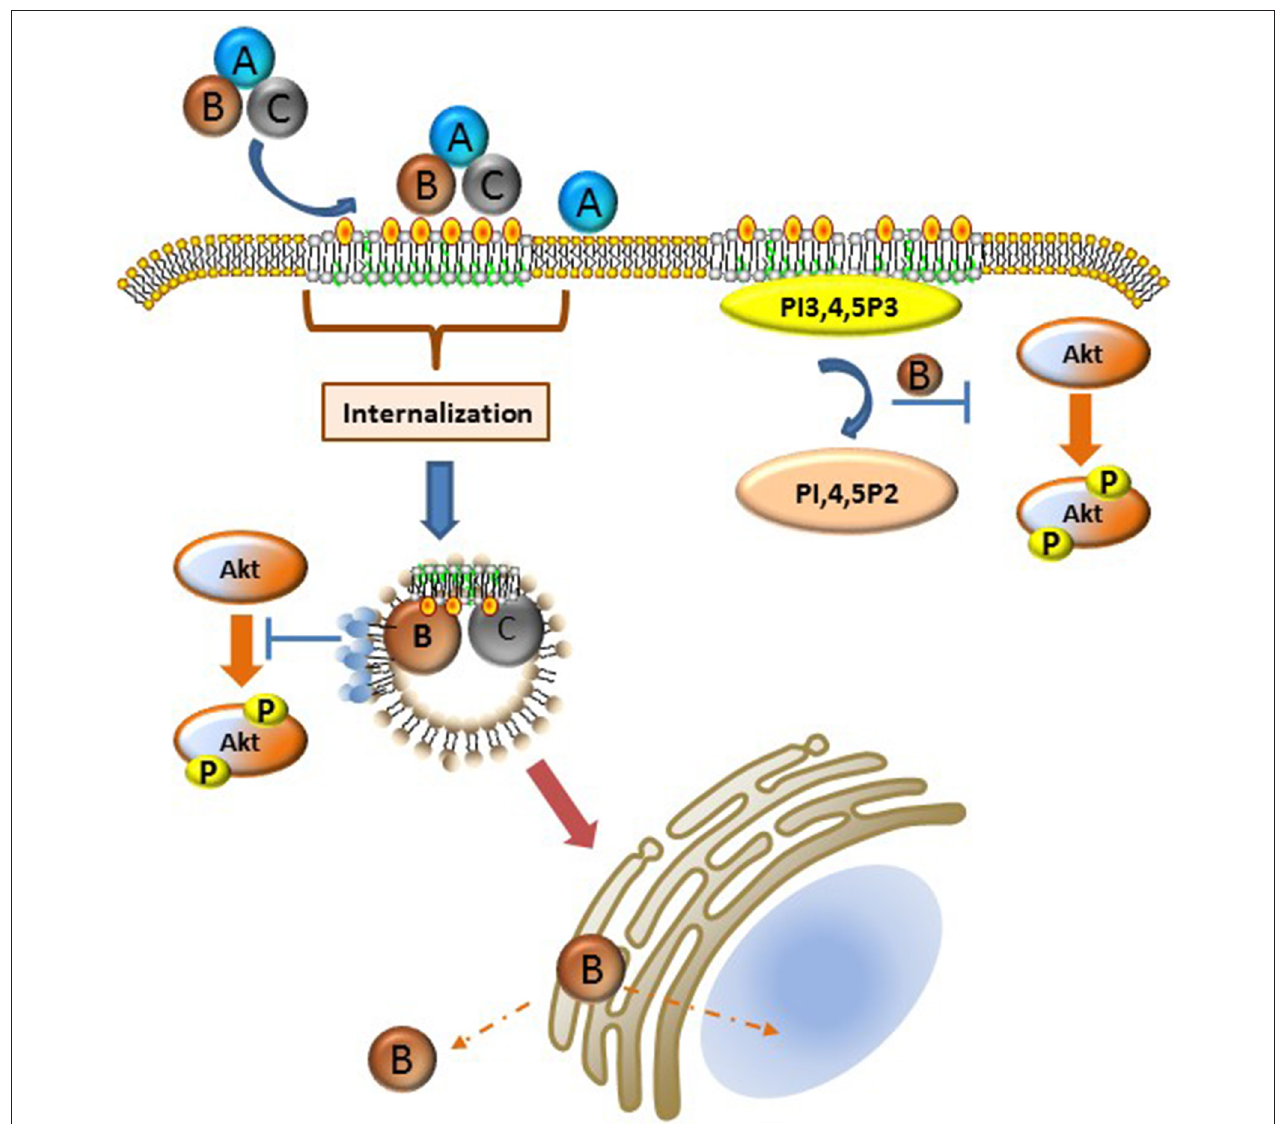
FIGURE 1 | Schematic representation of Cdt-cell surface association, internalization, and intracellular activity. Details of these processes are described in the text. Briefly, Cdt holotoxin binds cholesterol rich membrane rafts. Several different pathways have been implicated for the internalization of the CdtB and CdtC subunits; it is possible that the operative pathway may be Cdt sub type specific or host cell specific. Once internalized CdtB traffics to the Golgi, ER, and ultimately to the nucleus and/or cytoplasm. Internalized CdtB exerts toxicity either through its ability to act as a DNase and/or lipid phosphatase converting PI3,4,5,P3 to PI, 4,5P2 leading to PI-3K signaling blockade. Phosphoinositide pools, particularly PIP3, are likely plasma membrane associated, perhaps in the context of membrane rafts or a component of the endosomal substrate pool as indicated by the light blue circles on endosomes which represent PI3,4,5P3. Orange-yellow circles represent